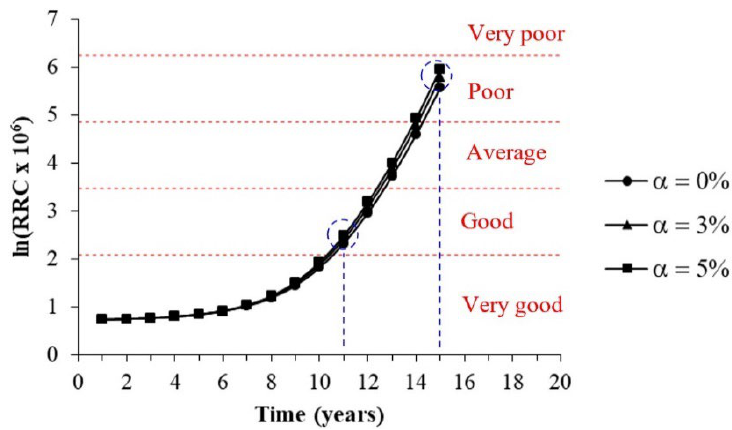
Figure 8. Deterioration of road-roughness condition in terms of ln(RRC×10 6